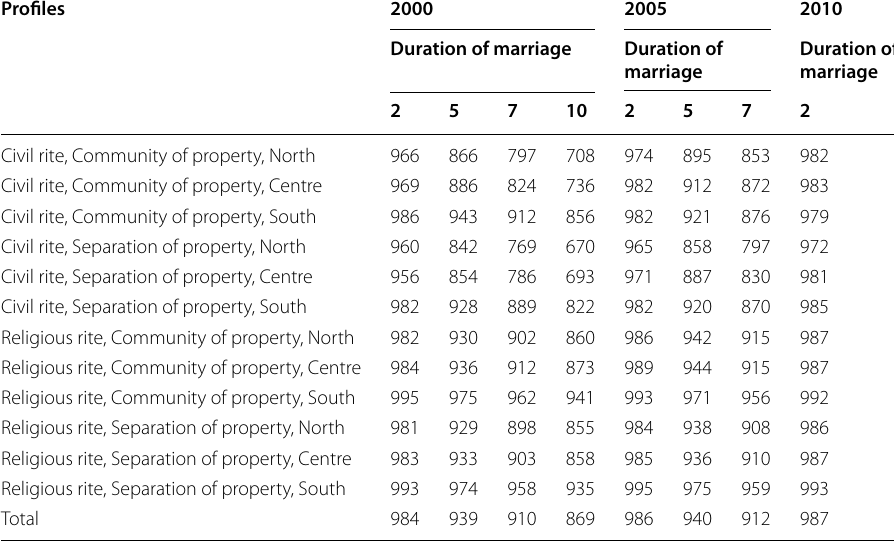
Source Author’s elaboration of Istat data on marriages and separations